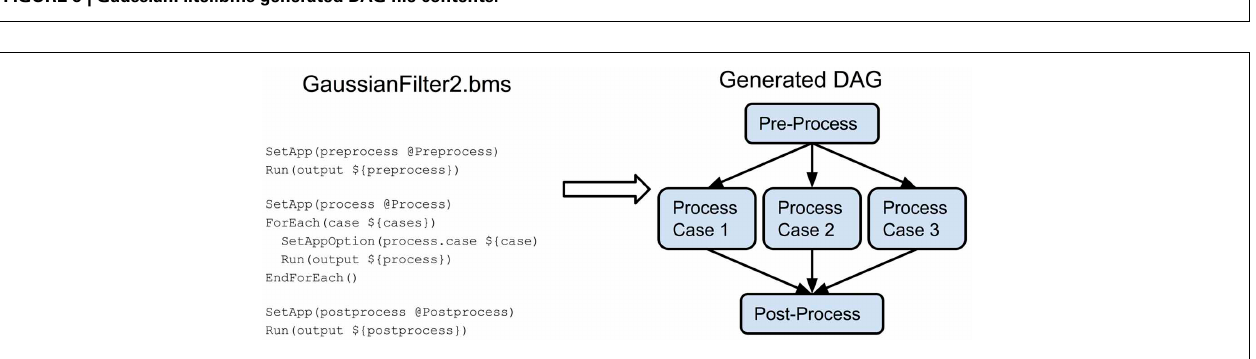
FIGURE 5 | GaussianFilter.bms generated DAG file contents.